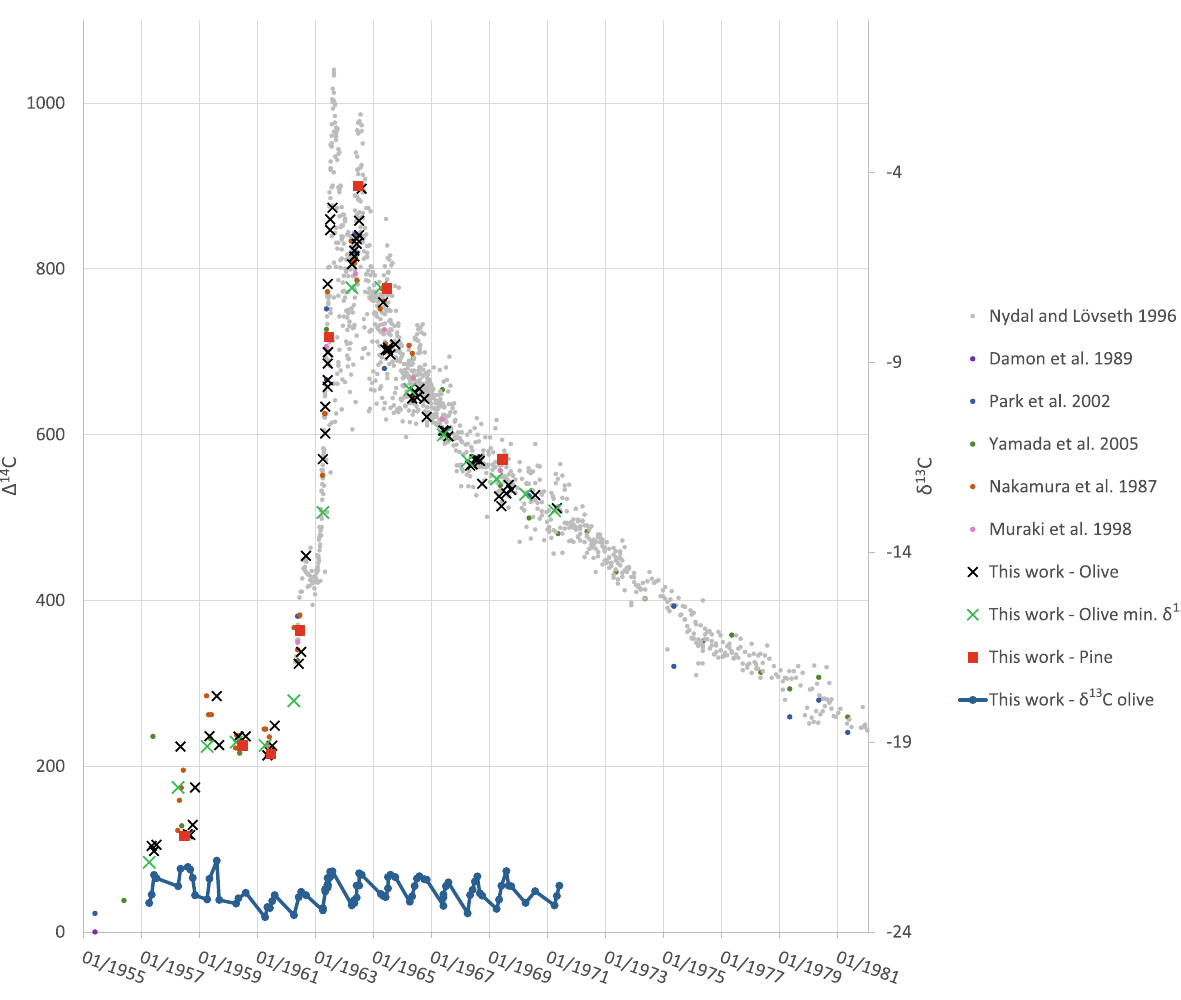
Figure 3. Radiocarbon data from olive wood compared to “bomb peak” calibration curve raw data. Radiocarbon levels for all olive wood contiguous samples are shown in comparison to all “bomb peak” raw data sources, which include atmospheric measurements 33 and tree ring data 34–38 . Green data points correspond to minimum δ 13 C values (from Fig. 2), and represent the beginning of a growing